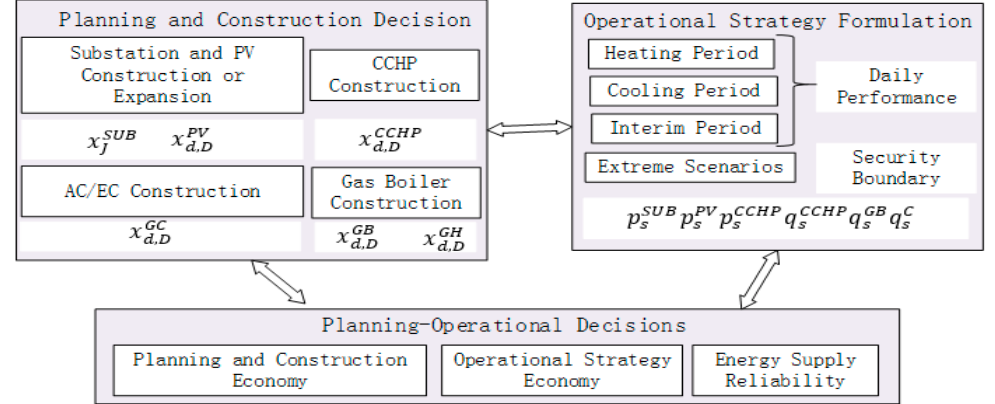
Figure 4. The main variables and decisions of the IEMG planning model.